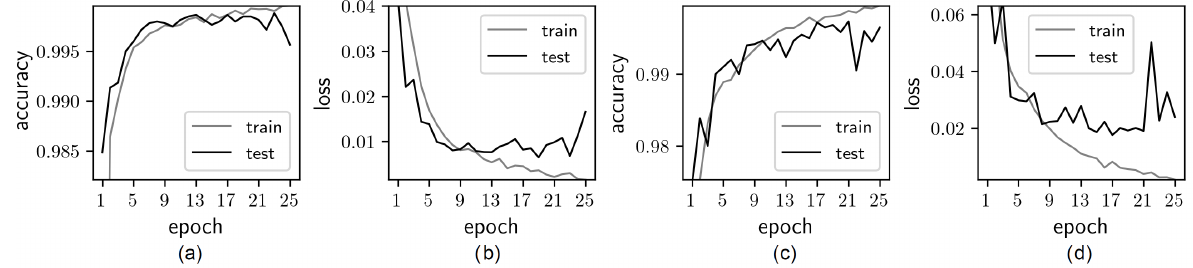
Figure 6. The training dynamics of the network: ( a , b ) depicts the accuracy and loss functions using the original data set; ( c , d ) correspond to the training dynamics of the network with the augmented data